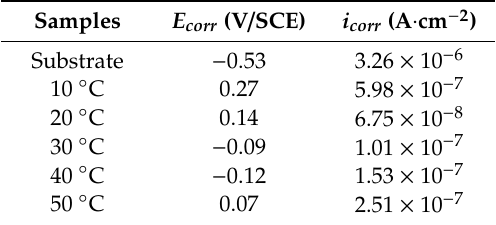
Figure 8. Potentiodynamic polarization curves recorded in 3.5 wt.% NaCl solution for the composite anodic film fabricated at different temperatures. Table 3. Corrosion potential ( E corr ) and corrosion current density ( i corr